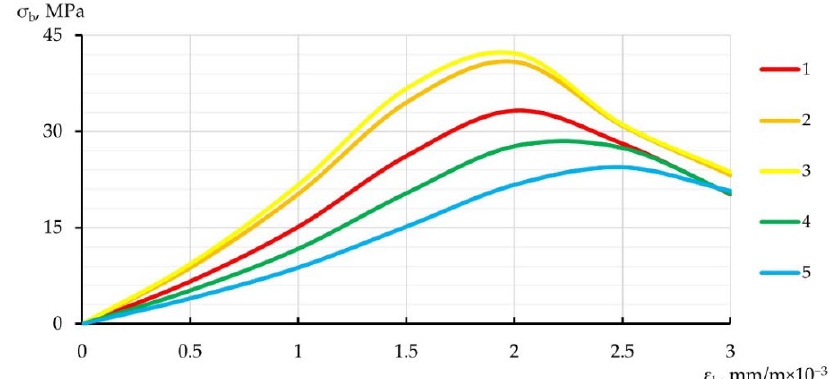
Figure 12. Stress-strain diagram in compression.